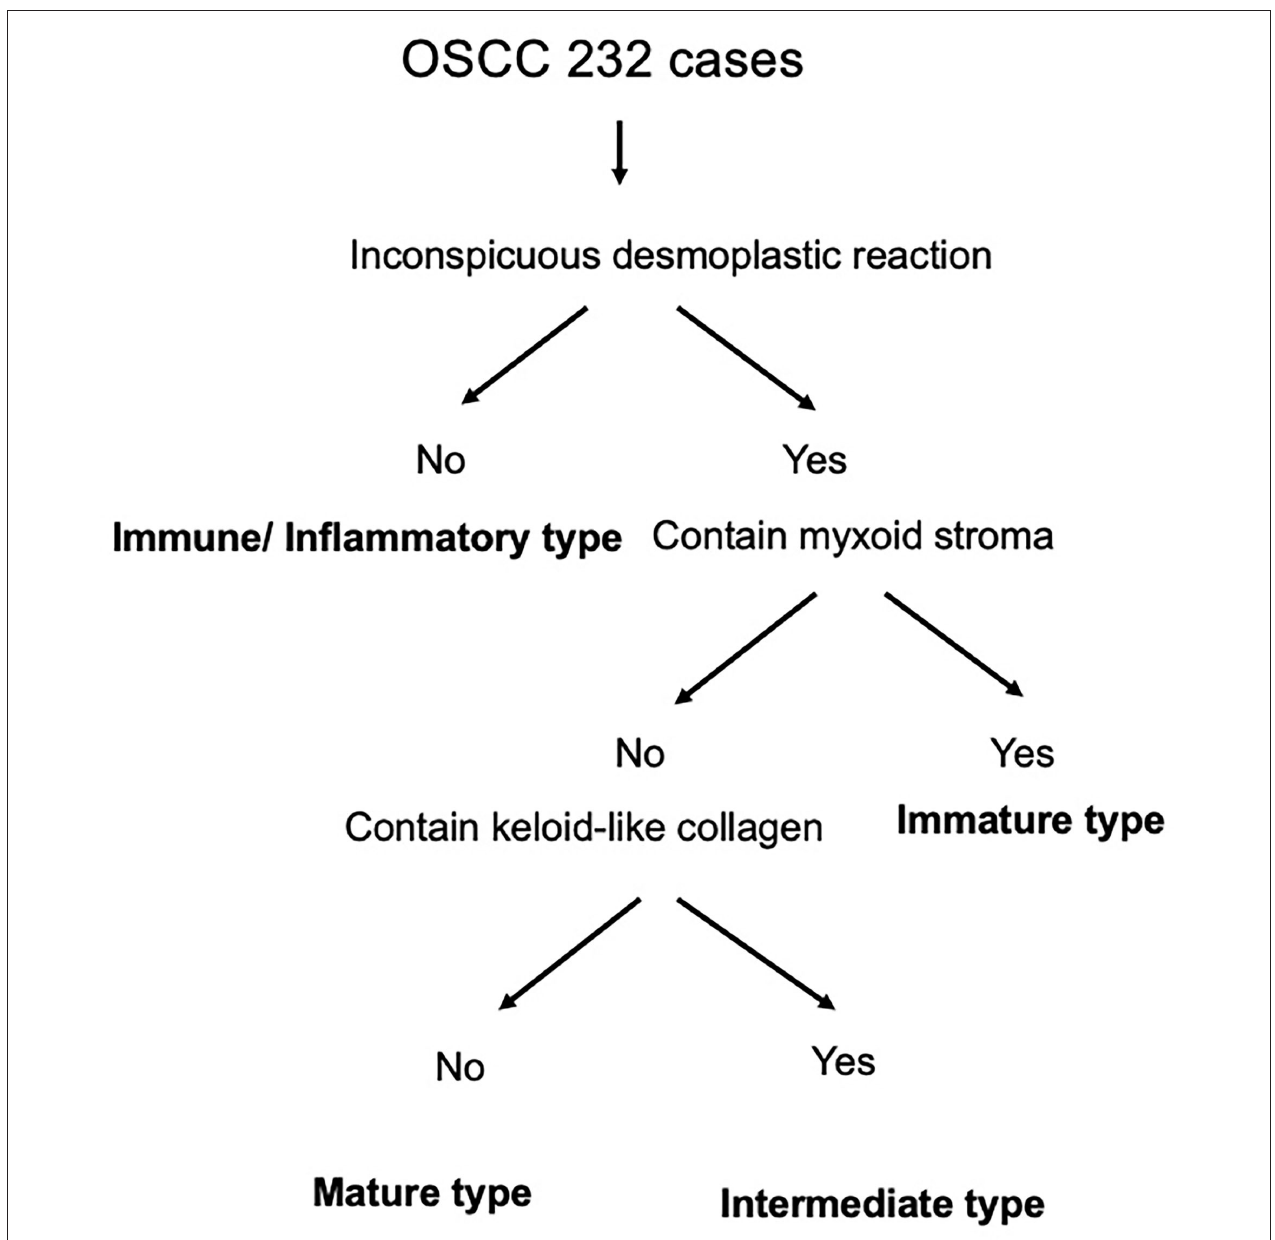
FIGURE 1 | Flow chart of the stromal pattern (SP) categorization